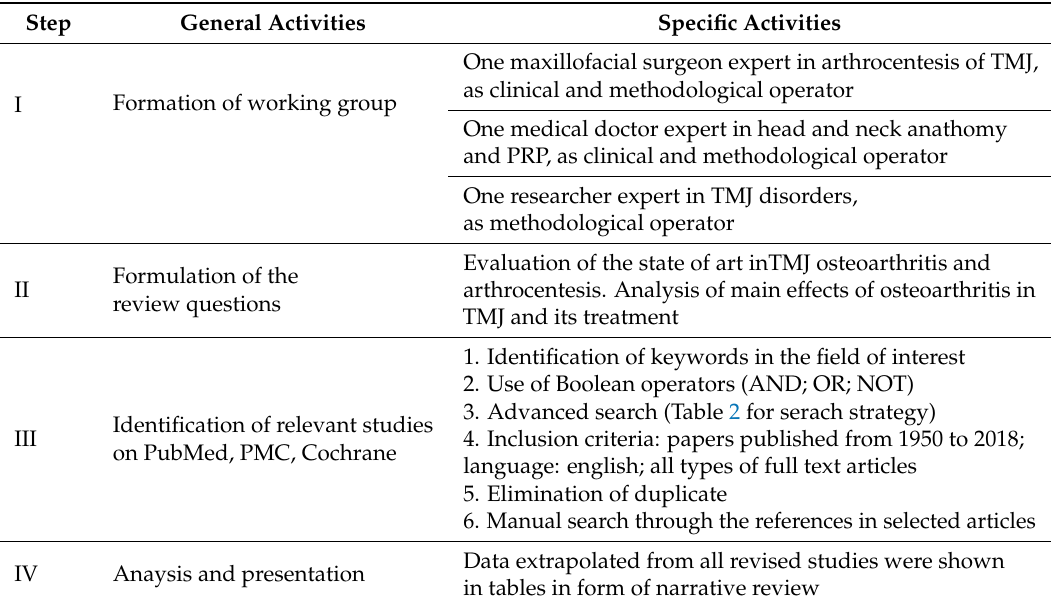
Table 1. Methodological approach to